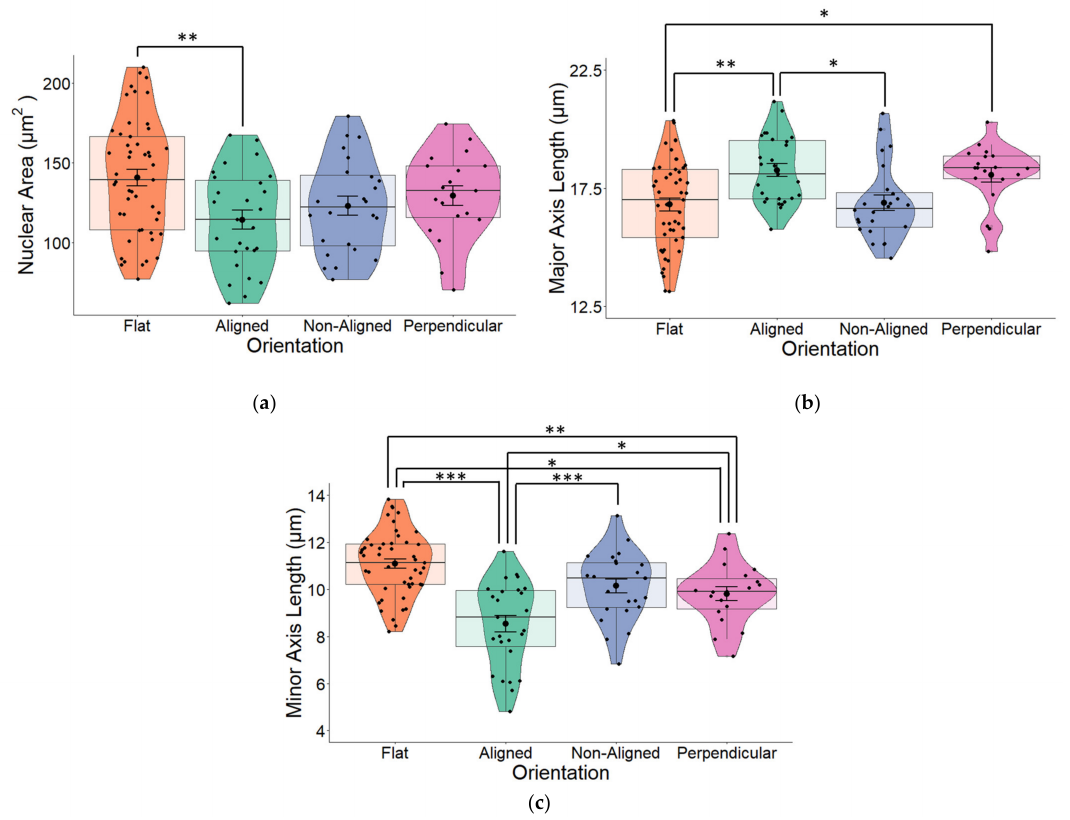
Figure 4. ( a ) The nuclear area of human SH-SY5Y cells grown on aligned or non-aligned scaffolds without application of an EF. Cells were grown either on plain glass coverslips (control) or on electrospun (ES) glass coverslips. Electrospinning was performed to produce either aligned or non- aligned fibers. Cells growing on aligned fibers that were perpendicular to the direction of the electrical field (EF) were classified as ‘perpendicular’. Cells were fluorescently stained with DAPI to identify the nucleus. Measurement of the surface area of the nuclei revealed substantial variations based on the medium on which it was grown. Whilst cells grown on scaffolds all displayed smaller nuclear surface areas (one-way ANOVA p = 0.009), those grown on aligned scaffolds displayed significantly smaller surface areas (Tukey post-hoc p = 0.006) compared to control cells grown on plain glass coverslips. ( b ) Quantification of nuclear length along the major (long) axis of non-stimulated SH-SY5Y cells grown on glass coverslips that were either plain (flat) or coated with electrospun PCL fibers in either an aligned or non-aligned manner. One-way ANOVA p < 0.001. Measurement of the cell nuclei along the major (long) axis revealed that cells grown on aligned fibers that were also aligned with the EF and cells grown on aligned fibers perpendicular to the EF had significantly longer nuclei compared to those grown on either flat (plain coverslips–control) or non-aligned fibers (post-hoc Tukey p = 0.002 and p = 0.031 respectively). The major axis of non-aligned cells was significantly smaller than aligned cells ( p = 0.02). ( c ) Quantification of nuclear length along the minor (short) axis of non-stimulated SH-SY5Y cells. One-way ANOVA p < 0.001. Measurement of the cell nuclei along the minor (short) axis revealed that all cells grown on electrospun fibers had significantly narrower/short nuclei compared to those grown on flat (plain coverslips–control). Post-hoc Tukey * p < 0.05, ** p < 0.01, *** p < 0.001 Flat n = 49, aligned n = 27, non-aligned n = 24, perpendicular n =